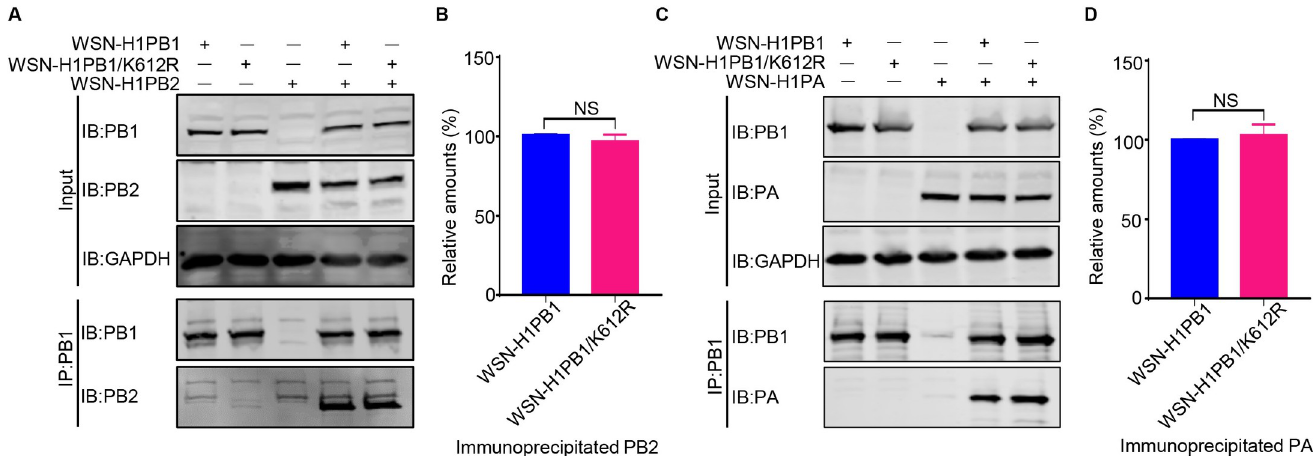
Fig 6. SUMOylation at K612 of PB1 has no effect on the interaction of PB1 with PB2 or PA. (A) PB1/K612R mutation does not affect the PB1-PB2 interaction. HEK293T cells were transfected individually or in combination as indicated with plasmids expressing WSN-H1PB1 or WSN-H1PB1/K612R mutant, and WSN-H1PB2. Forty-eight hours later, cell lysates were immunoprecipitated with a mouse anti-PB1 mAb, followed by western blotting with antibodies against PB1 and PB2. (B) Quantification of immunoprecipitated PB2 in (A). Band intensities of western blots from three assays were quantified by using ImageJ software, and the amount of precipitated PB2 was normalized to that of precipitated PB1. (C) PB1/K612R mutation does not affect the PB1-PA interaction. HEK293T cells were transfected individually or in combination as indicated with plasmids expressing WSN-H1PB1 or WSN-H1PB1/K612R mutant, and WSN-H1PA. Forty-eight hours later, cell lysates were immunoprecipitated with a mouse anti-PB1 mAb, followed by western blotting with antibodies against PB1 and PA. (D) Quantification of immunoprecipitated PA in (C) as described in (B). The amount of precipitated PA was normalized to that of precipitated PB1. The results are expressed as the mean ± SD of three assays and the significance was tested with a Student’s t-test (B, D). NS, not significant.